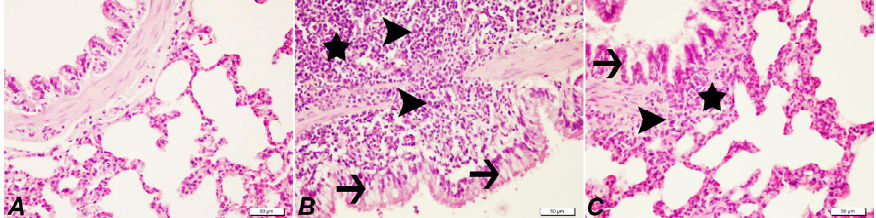
Figure 4. Lung histopathology of experimental groups (hematoxylin and eosin staining (40 × ), Bar: 50 µ m. Control group ( A ), normal histological appearance; DEN group ( B ), peribronchiolar lymphohistiocytic cell infiltration (star), alveolar macrophages (arrowhead), and differentiation disorders due to epithelial degeneration (arrow); peribronchiolar lymphohistiocytic cell infiltration; DEN + SOR group ( C ), peribronchiolar cell infiltrations (star), alveolar macrophages (arrowhead) and epithelial degeneration (arrow). Control: healthy group (no treatment), DEN: diethylnitrosamine group, DEN + SOR: DEN + 10 mg/kg sorafenib. Table 1. Summary of the histopathological scores based on H&E staining results for lung tissues. Control Group